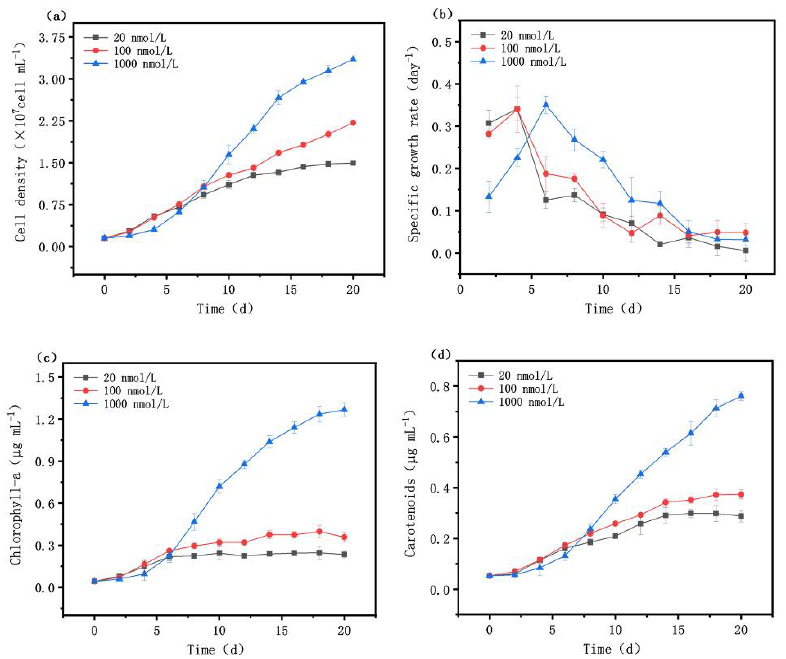
Figure 1. Effects of different iron concentrations on the growth of Microcystis aeruginosa . ( a ) Cell density; ( b ) specific growth rate; ( c ) chlorophyll-a; ( d ) carotenoids.